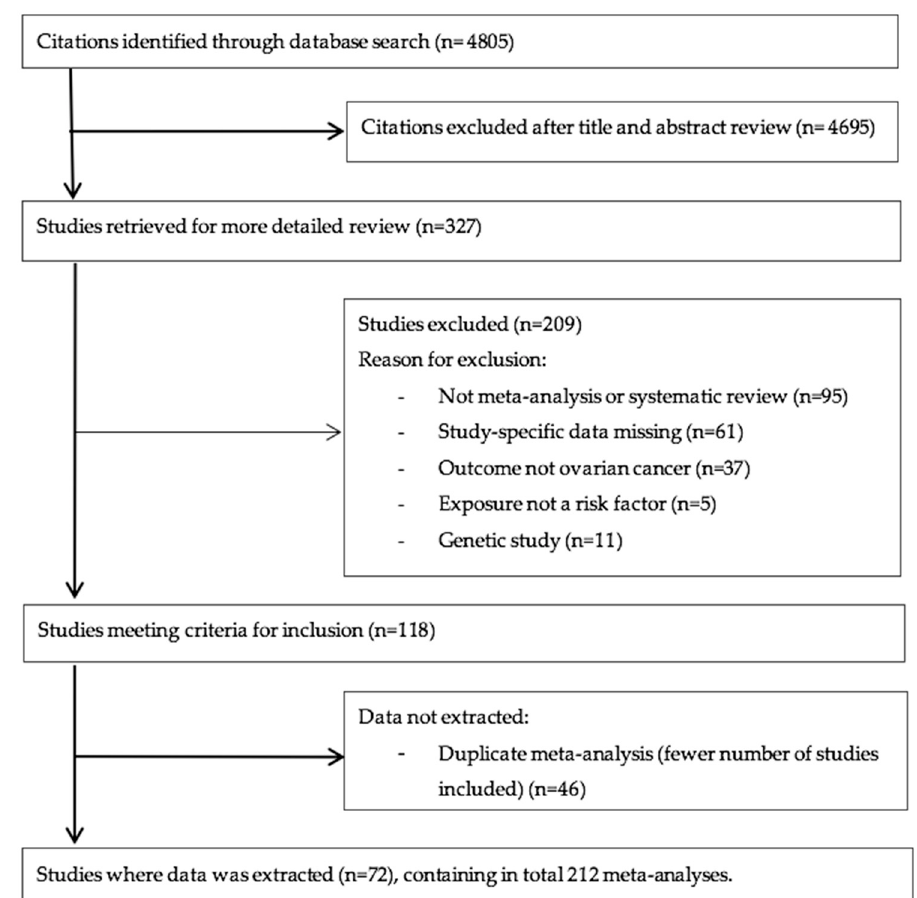
Figure 1. Flow diagram of literature search and study selection.